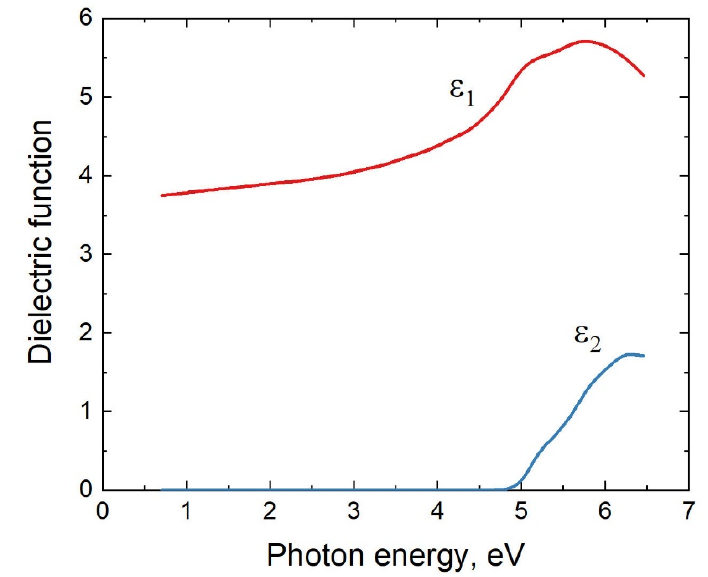
Figure 12. Dependence of the ordinary dielectric function of 𝜀 -Ga 2 O 3 on the photon energy. 𝜀 (cid:2869) is the real part of the dielectric function, 𝜀 (cid:2870) is its imaginary part.